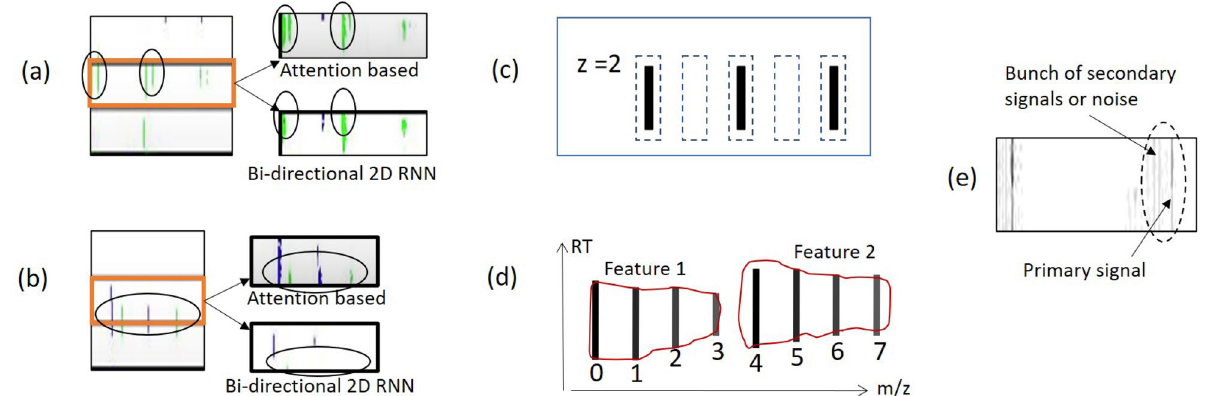
Figure 5. ( a ) and ( b ) are showing the comparison between attention-based mechanism and bi-directional 2D RNN. The orange rectangle is showing the target window. For each target window, detections by attention mechanism and bi-directional two-dimensional RNN are shown next to it, pointed by arrow signs. We see that the attention mechanism works better in separating closely residing features in ( a ) and detecting partially seen features in ( b ). ( c ) When isotope lists are passed to the IsoGrouping module with wrong frames (dotted rectangles) because of the wrong charge ( z = 4 ) detected by the IsoDetecting step, it results in discarding this whole group of frames as noise due to the inconsistency (blank frames) observed. ( d ) Adjacent feature problem. ( e ) Feature like noisy